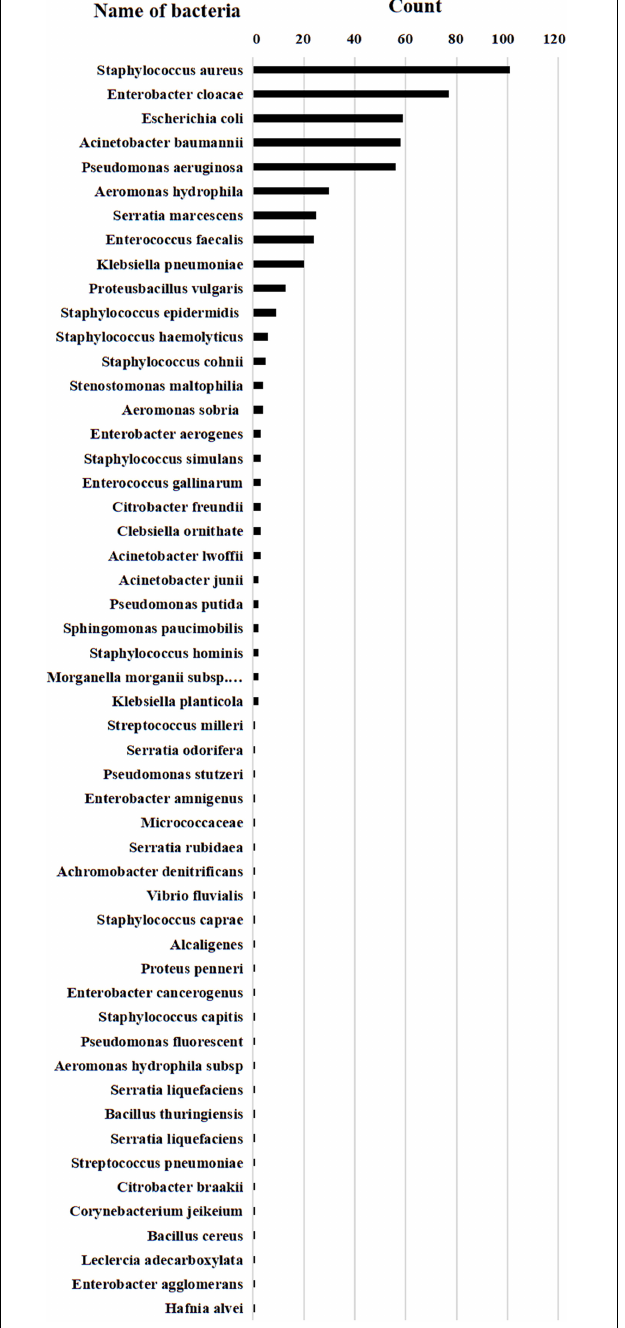
FIGURE 5 | Bacterial statistics. A total of 546 strains of 52 species of bacteria. A total of 101 strains of Staphylococcus aureus (including MRSA 48 strains, MSSA 53 strains), 77 strains of Enterobacter cloacae (including Enterobacter cloacae 72 strains, CRECL 5 strains), 59 strains of Escherichia coli (including Escherichia coli 27 strains and ESBL Escherichia coli 32 strains), 58 strains of Acinetobacter baumannii (including Acinetobacter baumannii 55 strains and CRAB 3 strains), 56 strains of Pseudomonas aeruginosa (including Pseudomonas aeruginosa 47 strains and MDR Pseudomonas aerogenosa 9 strains), 20 strains of Klebsiella pneumoniae (including Klebsiella pneumoniae 12 strains and ESBL Klebsiella pneumoniae 8